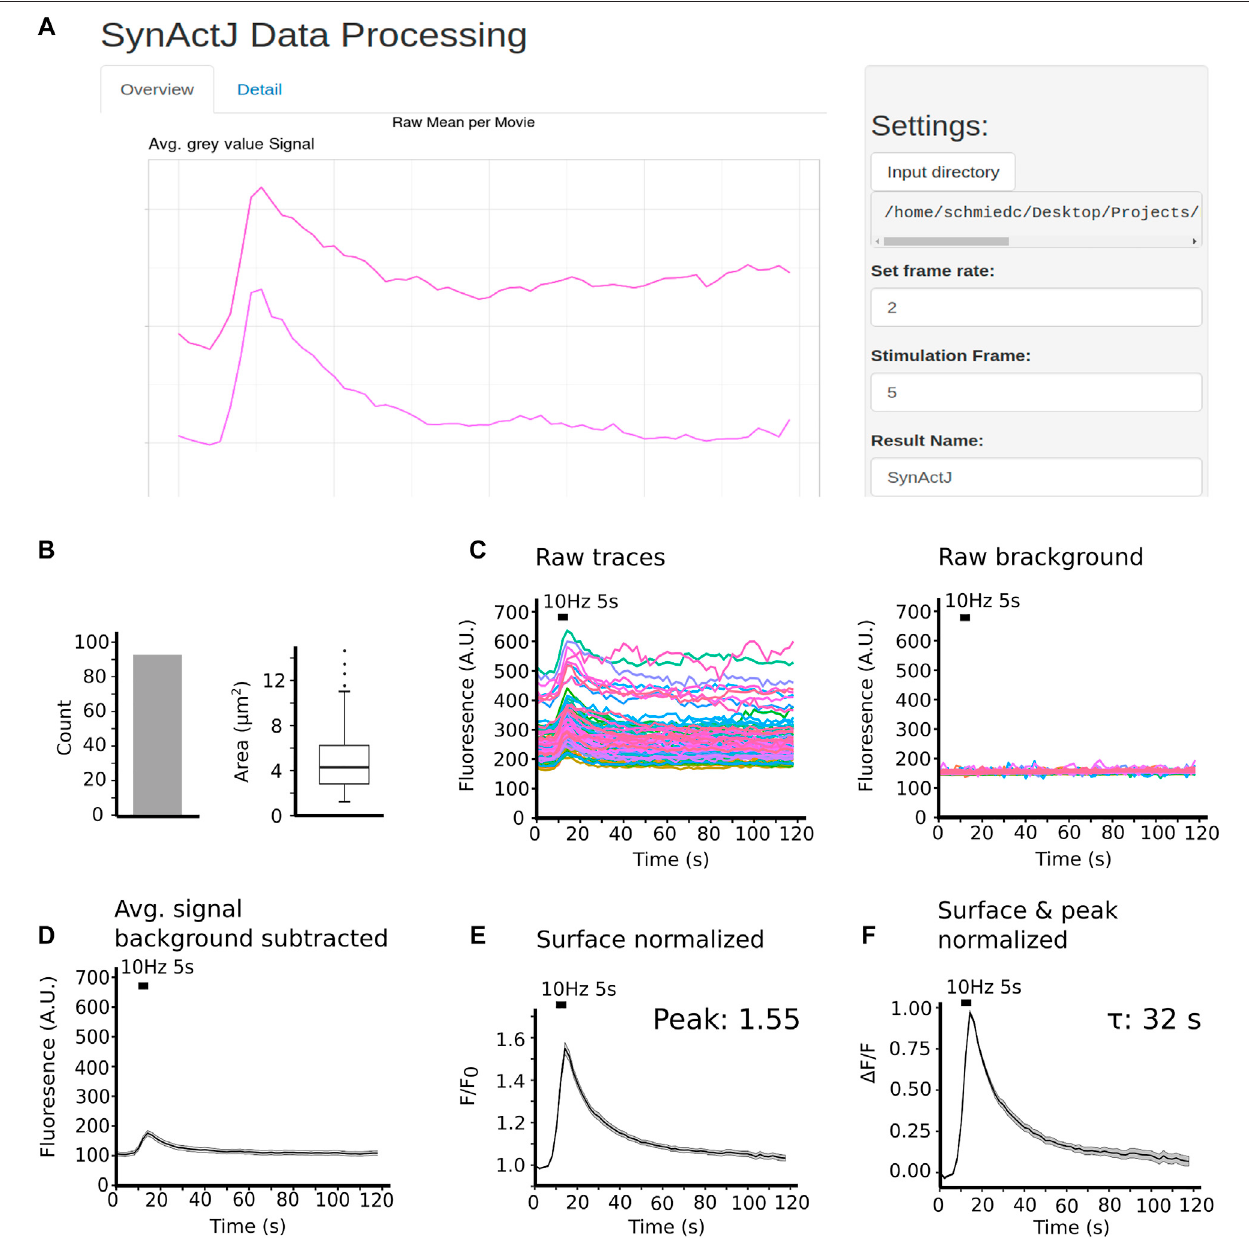
FIGURE 3 | SynActJ enables easy and rapid data processing and analysis via an R Shiny app. (A) The shiny app allows users to process and plot the result of the imageanalysisusingaGUI. (B) VitalparametersforqualitycontrolsuchasnumberofROIsandmeanareaofROIspermovieareplottedpertime-lapse. (C) Rawtracesof the signal as well as the background are extracted and plotted over time. (D) Per movie the average signal is computed, and the background value is subtracted. The average and background subtracted signal traces are surface (E) as well as peak normalized (F) .